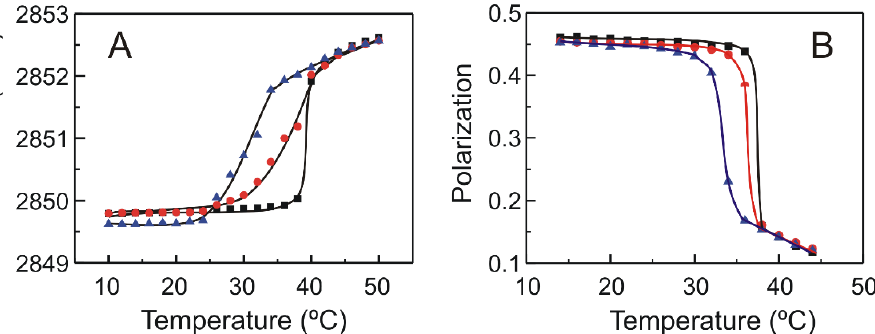
Figure 5. ( A ) Temperature dependence of the maximum of the symmetric methylene stretching vibration band, s ν (CH 2 ), exhibited by pure DMPS (squares) and DMPS containing TMBC at 0.07 (circles) and 0.20 (triangles) molar fractions. ( B ) Steady state fluorescence polarization as a function of temperature of DPH incorporated into membranes composed of pure DMPS (squares) and DMPS containing TMBC at 0.07 (circles) and 0.20 (triangles) molar fractions. Fluorescence polarization measurements, using a 1,6 ‐ diphenyl ‐ 1,3,5 ‐ hexatriene (DPH) probe, were carried out to establish this absence of changes in membrane fluidity.